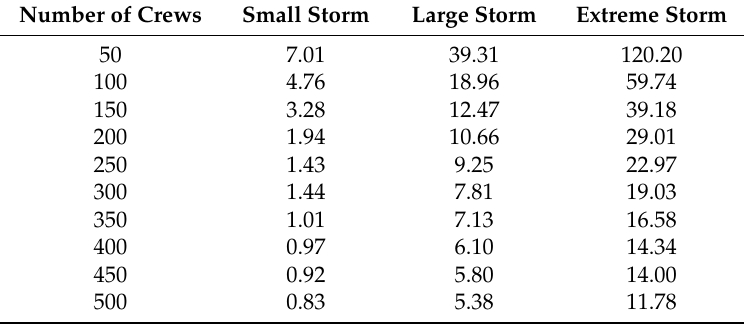
Table 7. Time to system restoration (in days) based on crew size from Figure